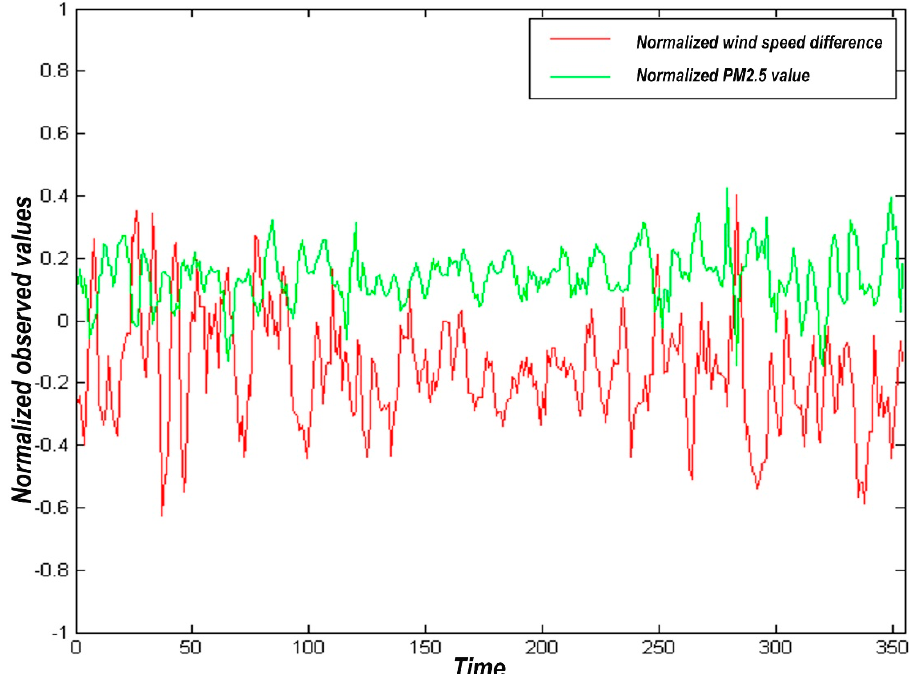
Figure 4. Correlation between wind speed difference and PM2.5 difference.